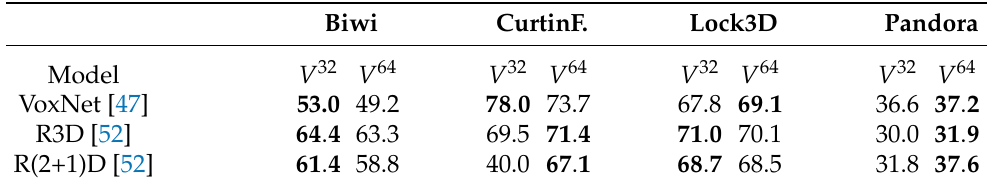
Table 5. Intra-dataset results, in terms of recognition accuracy, using voxels V . 32 and 64 specify the size m of the three-dimensional (3D) volume (see Section 2).